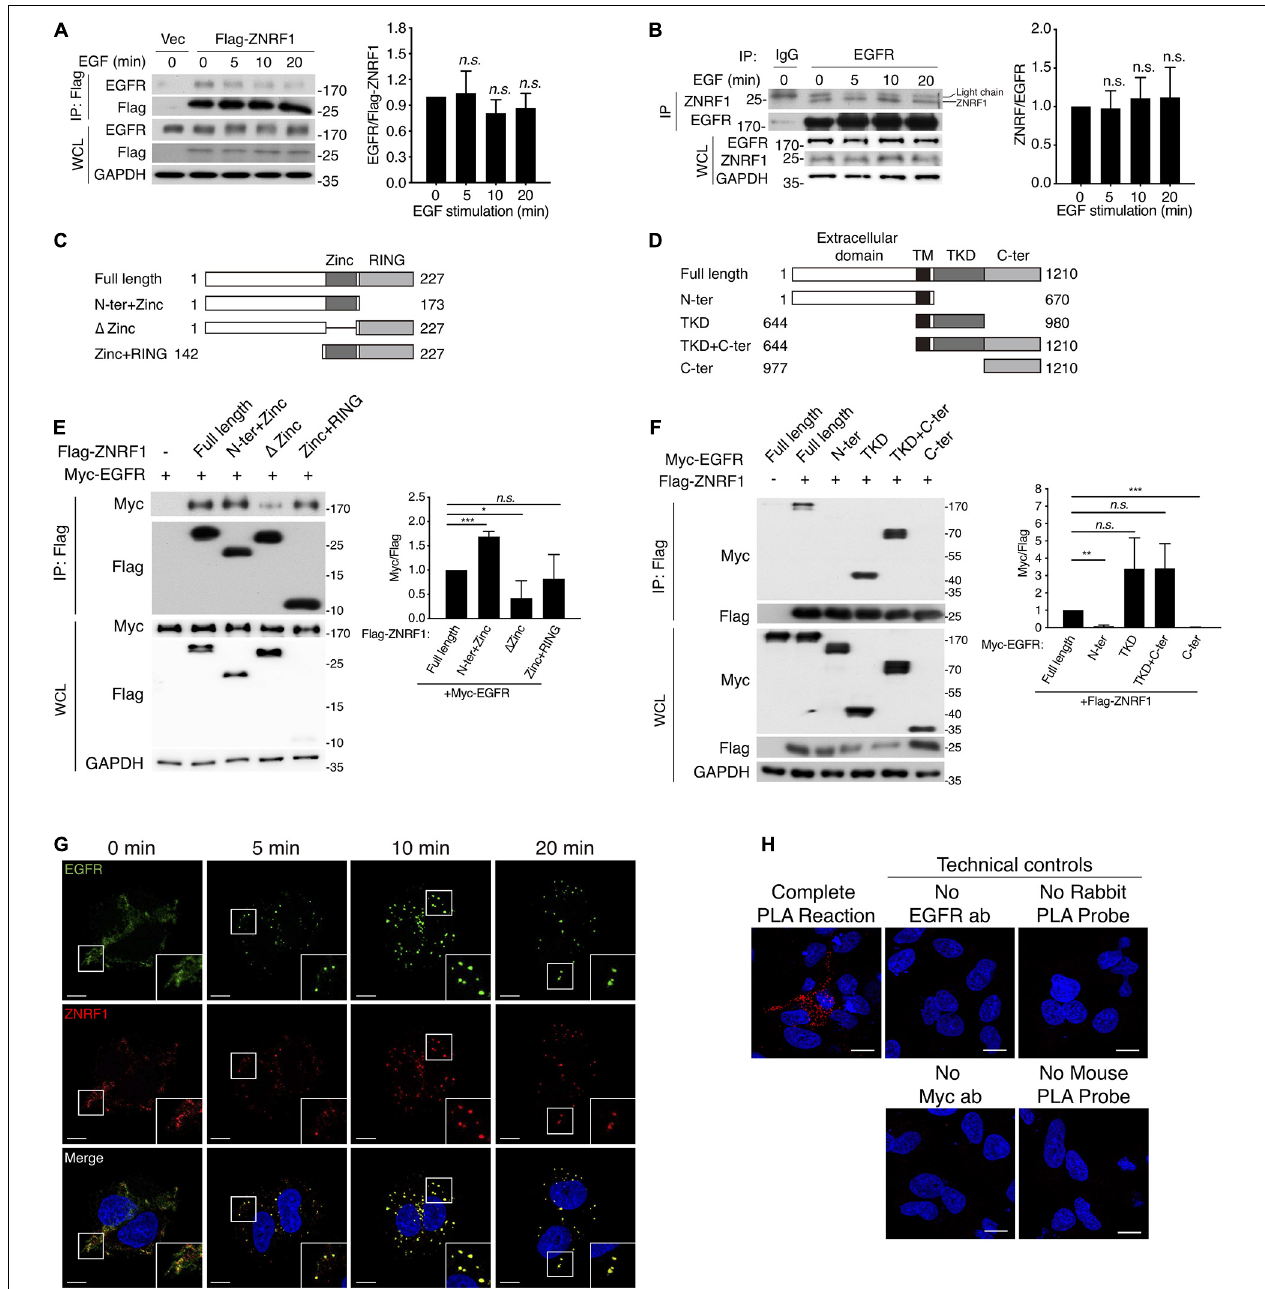
FIGURE 4 | ZNRF1 zinc domain interacts with EGFR TKD. (A,B) A549 cells expressing empty vector or Flag-ZNRF1 (A) and A549 cells (B) were serum-starved overnight and stimulated with 100 ng/mL EGF for the indicated times. EGFR was immunoprecipitated with the indicated antibodies. The immunocomplexes as well as whole cell lysates (WCL) were subjected to immunoblotting with the indicated antibodies. (C) Schematic diagram of full-length ZNRF1 and various deletion mutants of ZNRF1 with a C-terminal Flag tag. (D) Schematic diagram of full-length and truncated mutants of EGFR with a C-terminal Myc tag. TM, transmembrane domain; TKD, tyrosine kinase domain. (E) HEK293T cells were co-transfected with Myc-tagged EGFR and Flag-tagged full-length or truncated forms of ZNRF1 for 48 h, and interactions between EGFR and ZNRF1 were assessed by immunoprecipitation and immunoblotting with the indicated antibodies. (F) Flag-tagged ZNRF1 and Myc-tagged full-length or truncated mutants of EGFR were co-expressed in HEK293T cells, and the interactions between EGFR and ZNRF1 were determined by immunoprecipitation and immunoblotting with the indicated antibodies. Quantification of immunoblotting analysis data of three independent experiments are shown in the right panels. Results are presented as averages ± SEM. (G) A549 cells were serum-starved overnight and stimulated with 100 ng/mL EGF for the indicated times. Cells were fixed and co-stained with antibodies against ZNRF1 (red) and EGFR (green), and with DAPI (blue), followed by confocal microscopy. (H) A549 cells were transfected with Myc-tagged ZNRF1 for 48 h and then subjected to PLA using antibodies against EGFR and Myc. The detected interaction between ZNRF1 and EGFR is represented by red dots, and DAPI-stained cell nuclei are in blue. Scale bar, 10 µ m. The experiment was repeated two times with similar results. n.s., no significant; * P < 0.05, ** P < 0.01, *** P < 0.001 (Student’s t